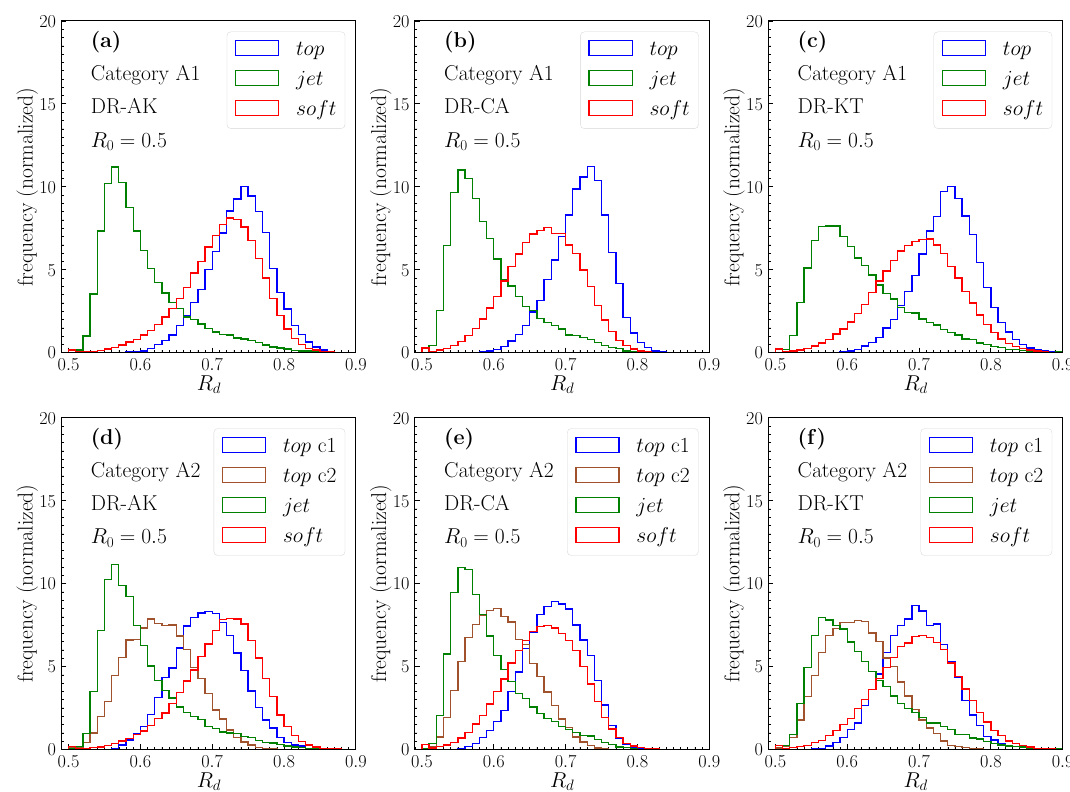
Figure 5 . Normalized distribution of the final radius R d of three different types of jets. The three plots in the top panel are for category A1 events while those in the bottom panel are for category A2 events. The conventions for the colours and labels ‘ top ’, ‘ jet ’, and ‘ soft ’ are the same as in figure 4. For category A2, ‘ top c1’ and ‘ top c2’ labels represent the two constituent jets of reconstructed top . The distributions are shown for DR-AK, DR-CA, and DR-KT algorithms in the panels (a,d), (b,e), and (e,f), respectively, with R = 0 . 5 0